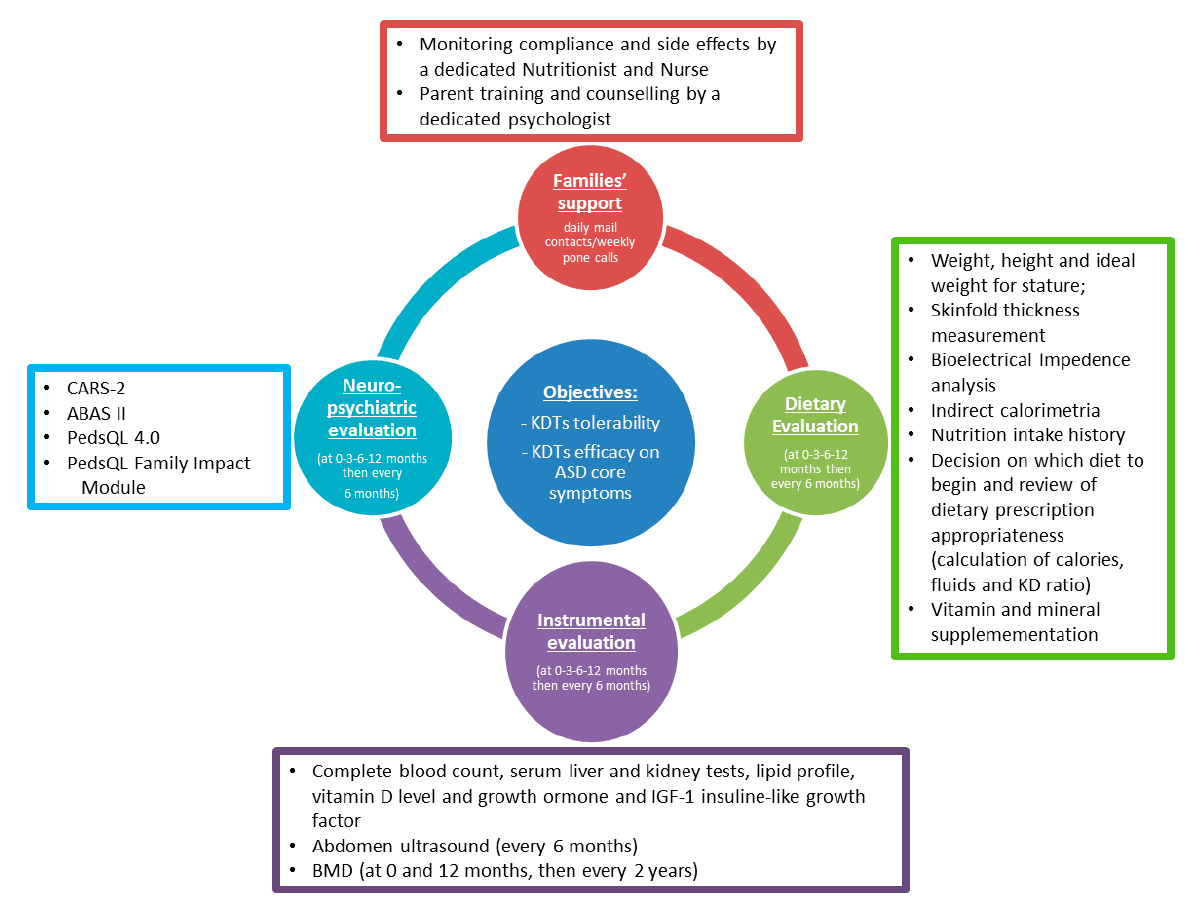
Figure 3. Proposal for a shared KDT protocol in ASD. Table 2. Laboratory assessment currently in use in our center for patients under KDTs.